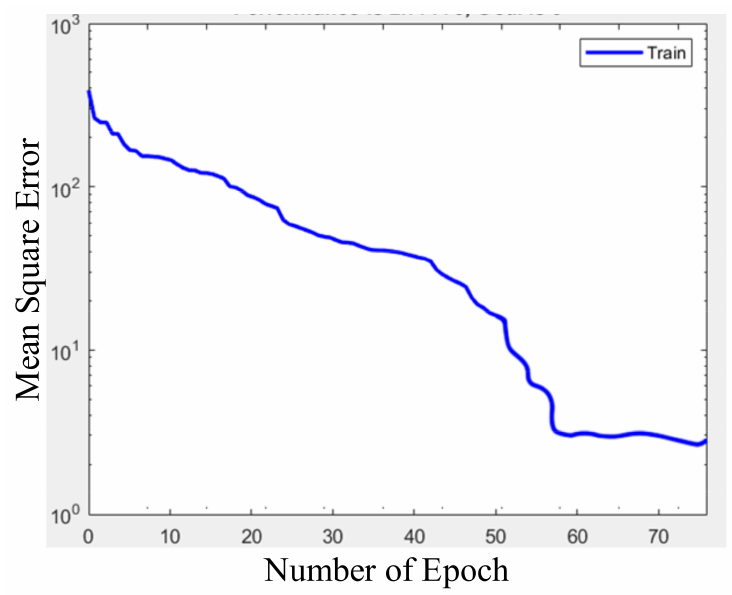
Figure 12. Performance graph of the water volume fraction predictor network.